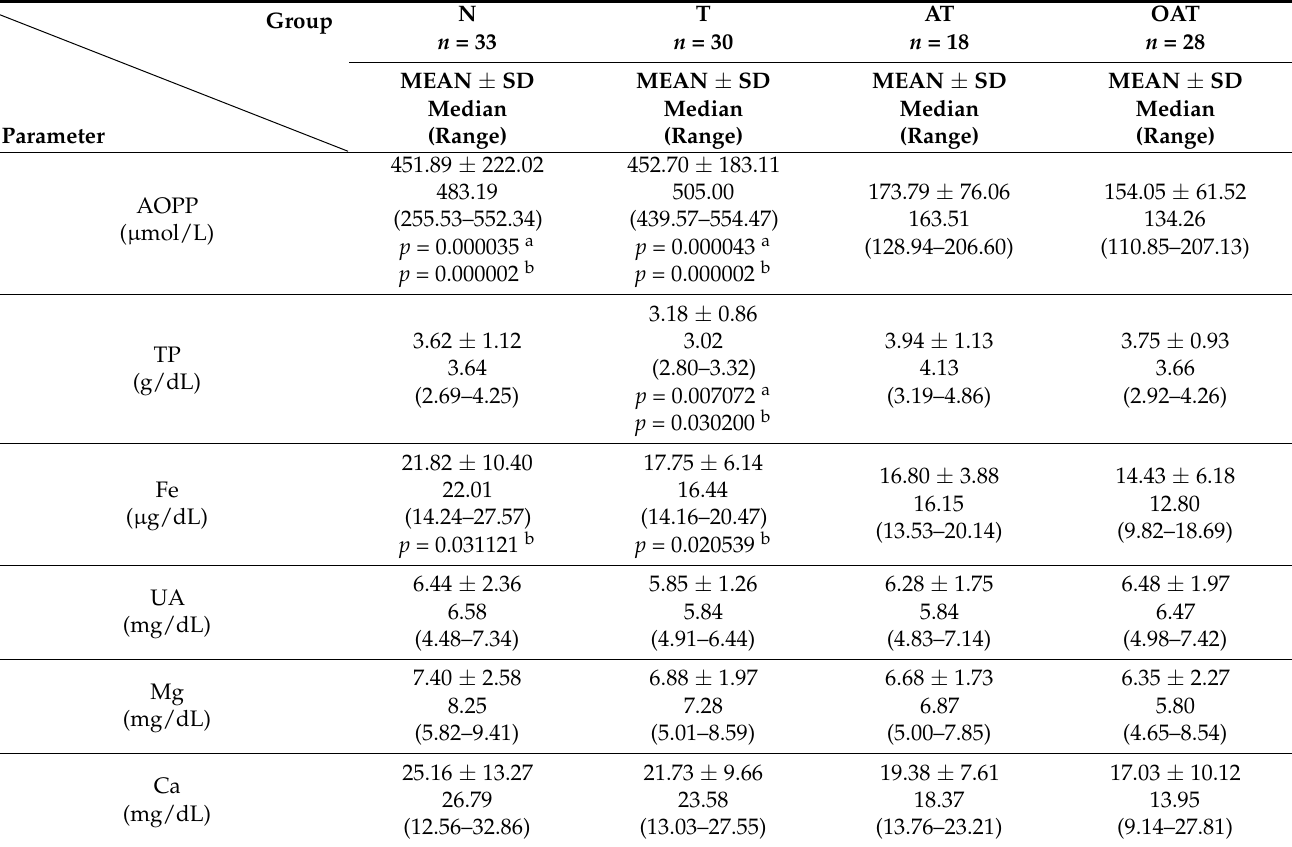
Table 1. Concentrations of seminal plasma parameters in male patients with fertility